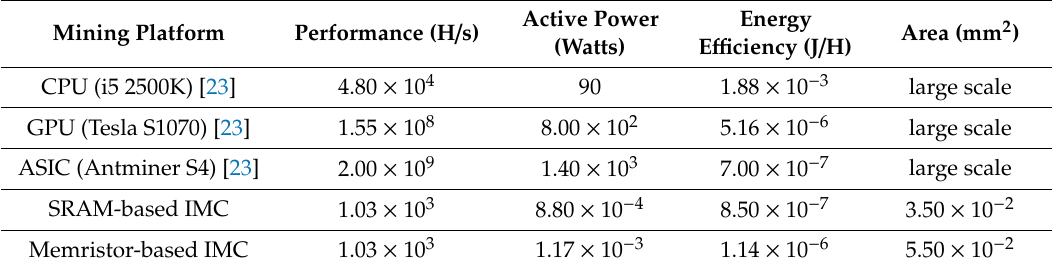
Table 7. Comparison of memristor-based IMC with central processing unit (CPU), graphics